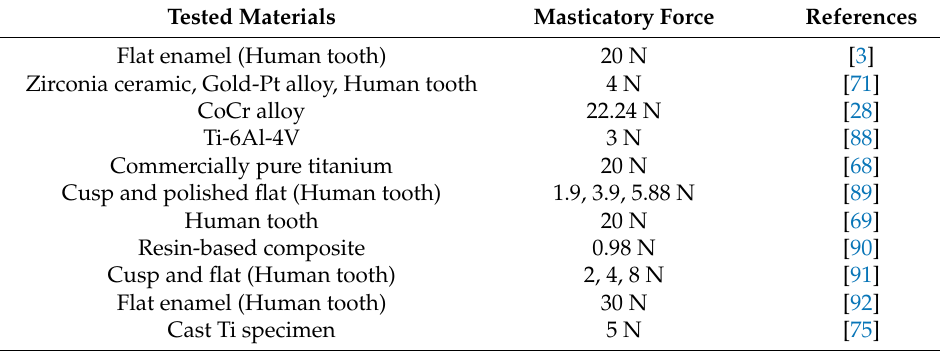
Table 2. Masticatory force ranges measured in previous research.